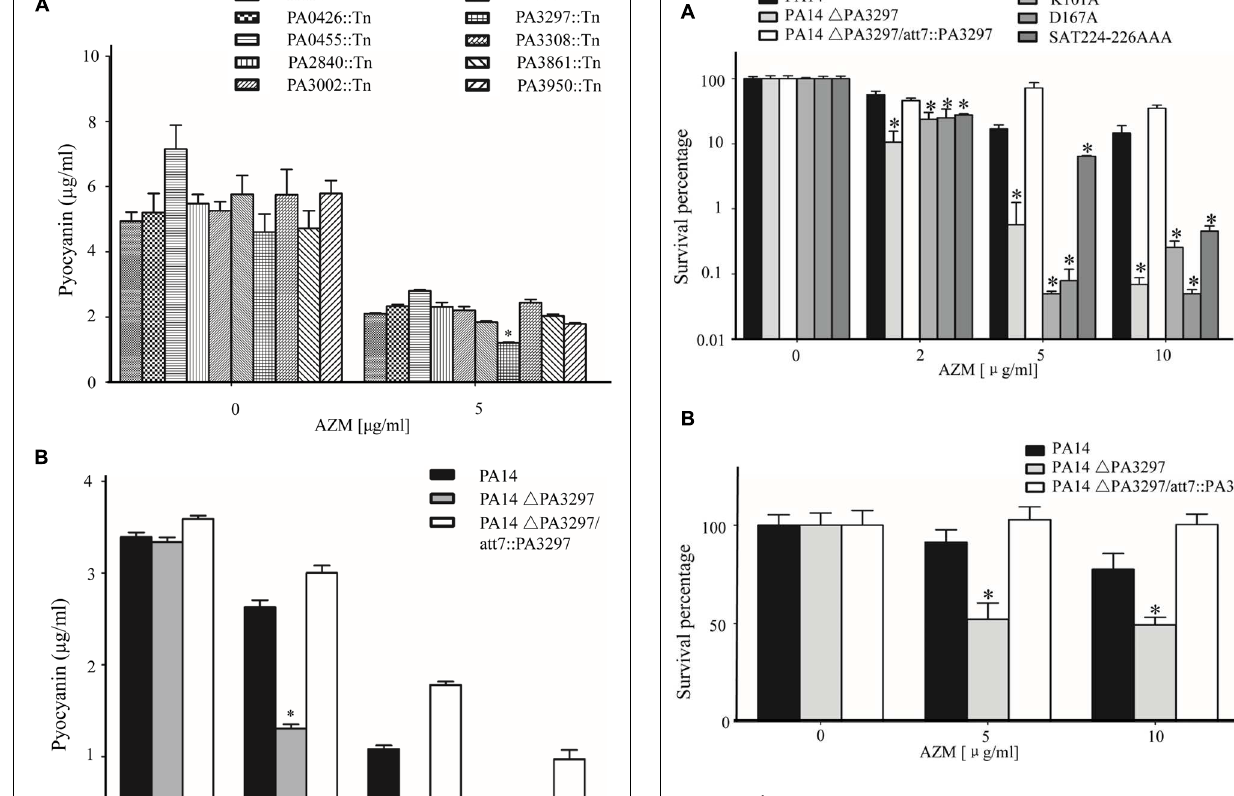
FIGURE 2 | Increased killing of the (cid:49) PA3297 mutant by AZM. (A) AZM-mediated killing of wild type PA14, the (cid:49) PA3297 mutant and the mutant complemented with wild type or the mutated PA3297. Stationary-phase bacteria were treated with 2, 5, or 10 µ g/ml AZM for 20 h at 37 ◦ C. The numbers of live bacteria were determined by serial dilution and plating. (B) AZM-mediated killing of biofilm. 24-h-old biofilms formed by wild type PA14, the (cid:49) PA3297 mutant and the complemented strain were treated with 5 µ g/ml, 10 µ g/ml AZM or not for 2 h. Bacteria in the biofilm were dissociated from the wells by gentle sonication. The viable bacteria were determined by serial dilution and plating. The averages and associated standard deviations from three replicates are shown. ∗ p < 0.05 compared to PA14 or the complemented strain by student’s t